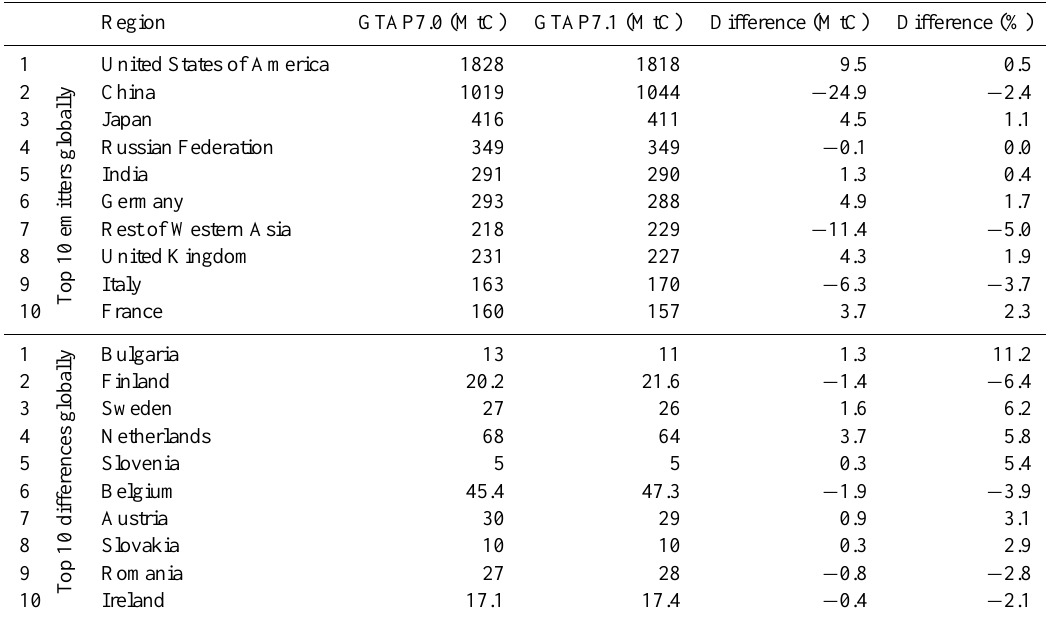
Table 7. The top 10 emitters and relative differences using the GTAP7.0 and GTAP7.1 databases with the same (GTAP7.0) emission dataset (2004). The main differences are for the EU27 countries, which is where the economic data is most